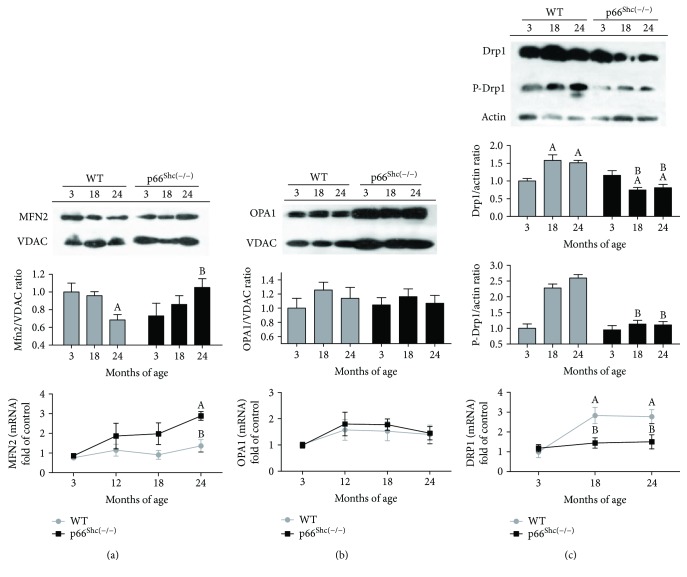
Effects of aging on mitochondrial dynamics in p66Shc(−/−) mouse brain. Immunoblot of proteins separated using SDS-PAGE from purified brain mitochondria or whole brain lysate and RT-qPCR of mRNA from TRIzol-treated brain extracts were performed. The expression of the fusion proteins Mfn2 (a) and Opa1 (b), and the fission protein Drp1 (c) with its (S616) phosphorylated active isoform and mRNA levels of mouse brain in WT (grey) and p66Shc(−/−) (black) groups were observed at 3, 18, and 24 months of age. VDAC protein expression in mitochondrial fraction, actin protein expression in whole brain lysates, and GADPH mRNA levels in RT-qPCR were used as standard, respectively (n > 5, for each experimental group). Values represent the mean ± SEM; A represents p < 0.05 compared to the 3-month-old group, B represents p < 0.05 between 18- or 24-month-old WT and p66Shc(−/−) respective groups, one-way analysis of variance (ANOVA) and Bonferroni post hoc test.